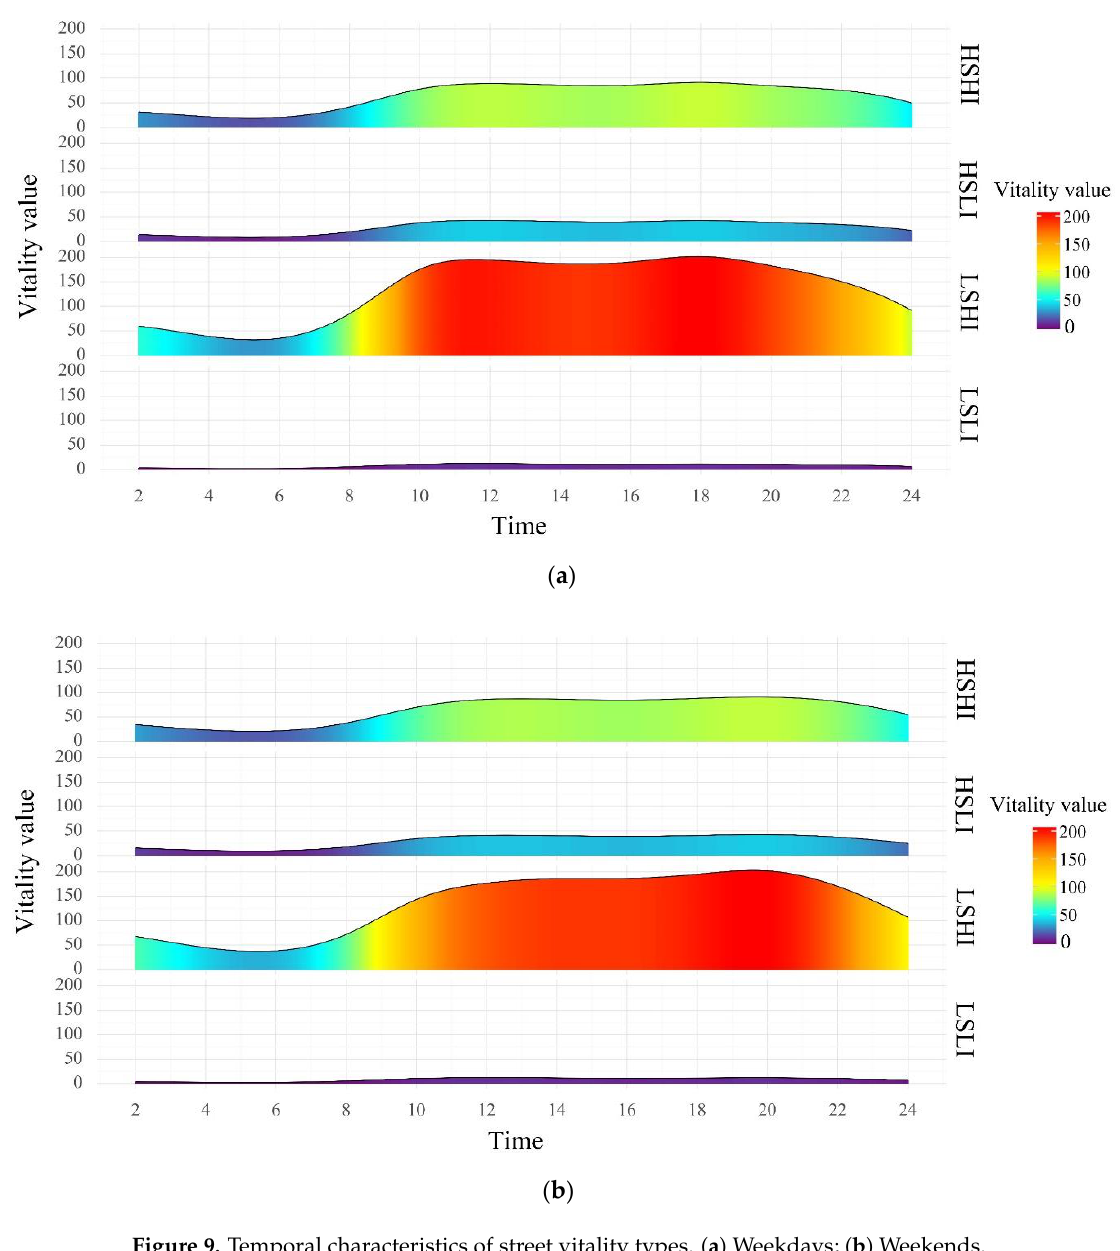
( b ) Figure 10. Comparison of the dynamic evaluation index of street vitality types on weekdays and weekends. ( a ) Vitality intensity; ( b ) Vitality stability. 4.4. Influential Factors of Street Vitality Types We used the POI indicators to analyze the influencing factors of land use on street dynamic vitality. Table 3 shows the results of Xining City’s land use indicators introduced in Section 3.3. As five streets had missing POI data, we calculated the average values of their vitality type indicator. Figure 11 shows the land use composition of the street vitality types in Xining city’s main urban area.